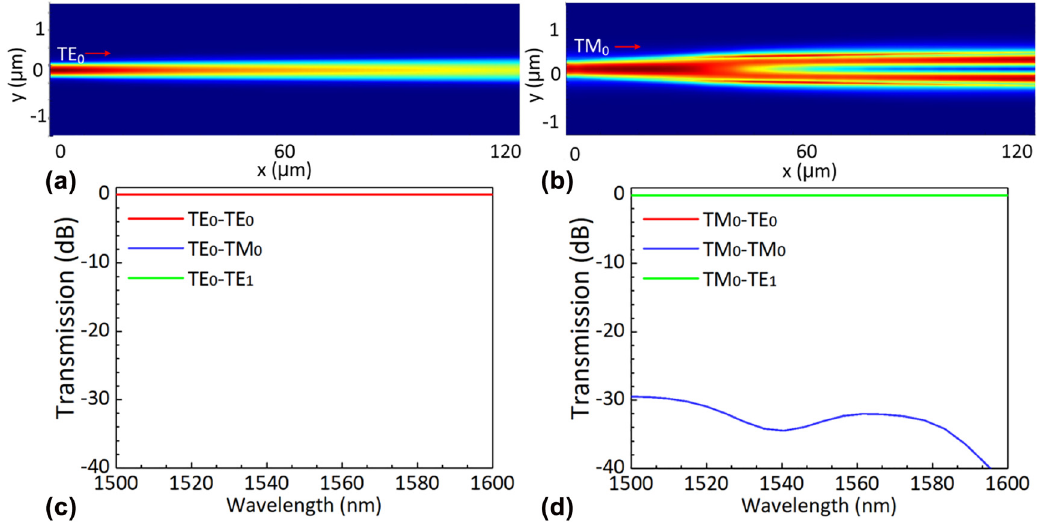
(a) and TE (b) modes in region R 0 1